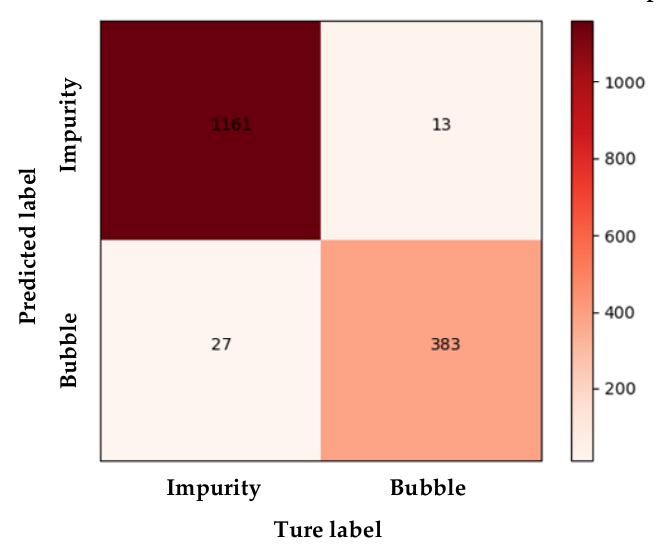
Figure 10. Confusion matrix of impurity and bubble identification results.